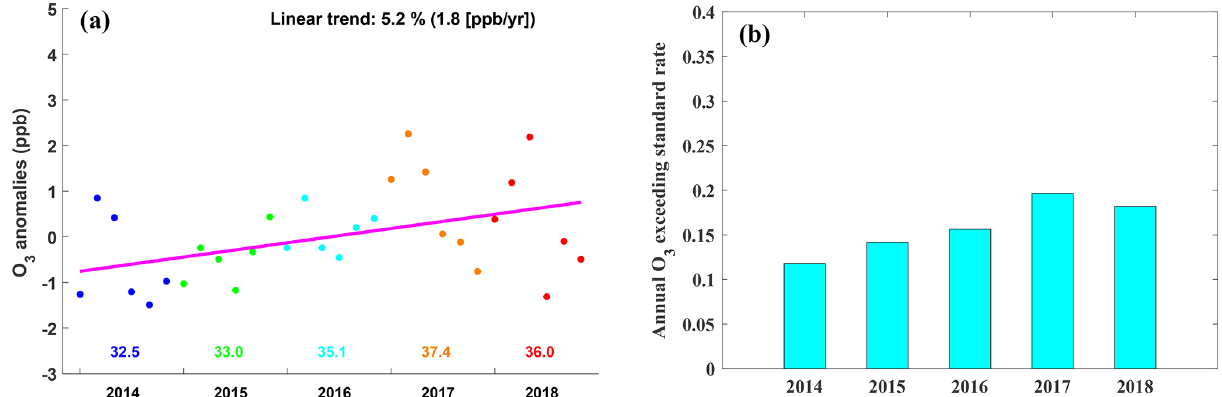
Figure 1. (a) Anomalies of monthly average O 3 concentration from April to September during 2014–2018. The solid purple line represents the linear fitted curve ( y t = − 0 . 808 + 0 . 052 t ), and the colored numbers represent the annual (April–September) mean O 3 concentration. (b) Annual (April–September) variation in the days with O 3 exceeding the national